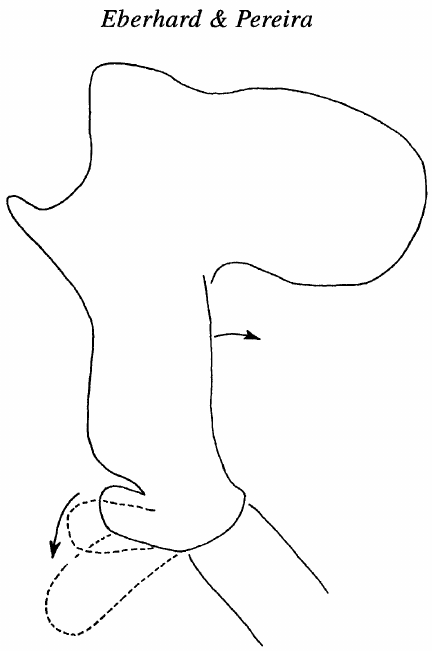
Fig. 5. Diagrammatic representation of the movements of the basal sac of the dis- tiphallus when it inflates (dotted lines). As the sac inflates the distiphallus moves in the opposite direction